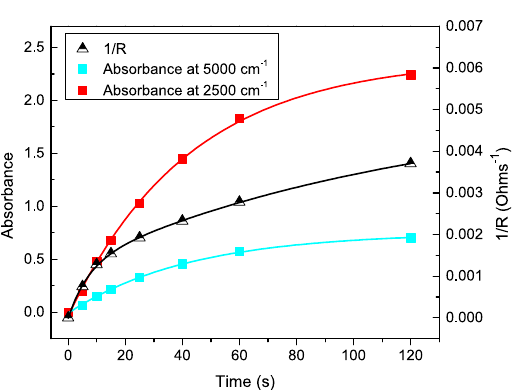
Figure 4. IR absorption (left axis) and conductance (right axis) versus light exposure duration (405 nm wavelength). Solid lines are exponential fits to the